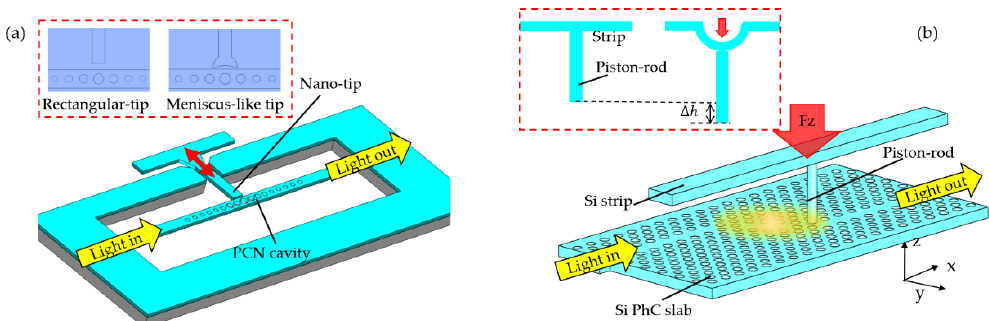
Figure 8. Schematics of the tunable PhC cavities based on near-field probe perturbation: ( a ) moveable probe-based single PCN cavity (inset: close-up view on two probe tips) [42]; ( b ) PhC side-coupled piston-rod microcavity (inset: depth variation Δ h due to the strain displacement) [89].